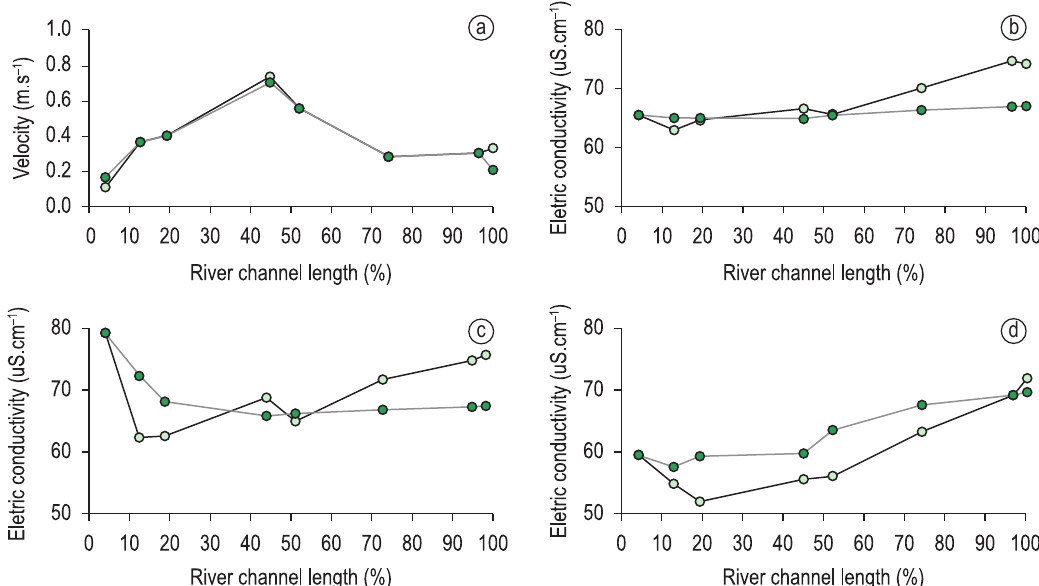
Figure 6. Electric conductivity variation (µS.cm -1 ) in Canha River, during the spring (a - September), summer (b - January), autumn (c - April) and winter (d - July) periods, respectively. ● : observed electric conductivity; “ ● ”: simulated electric